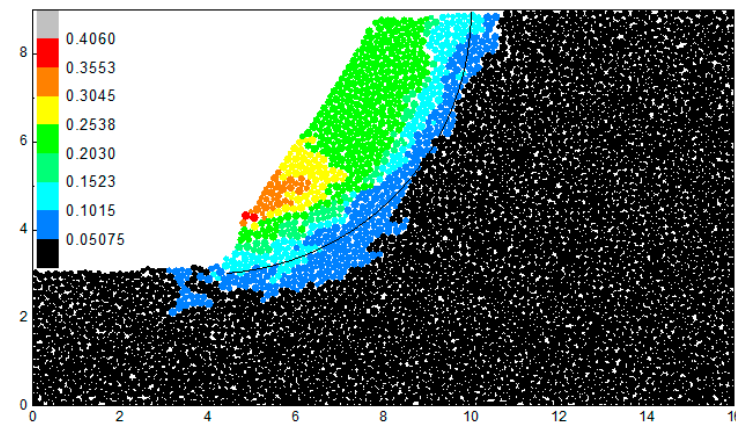
Figure 13. The particle displacement at the 10,000th step after the reduction of mesoscopic parameter.